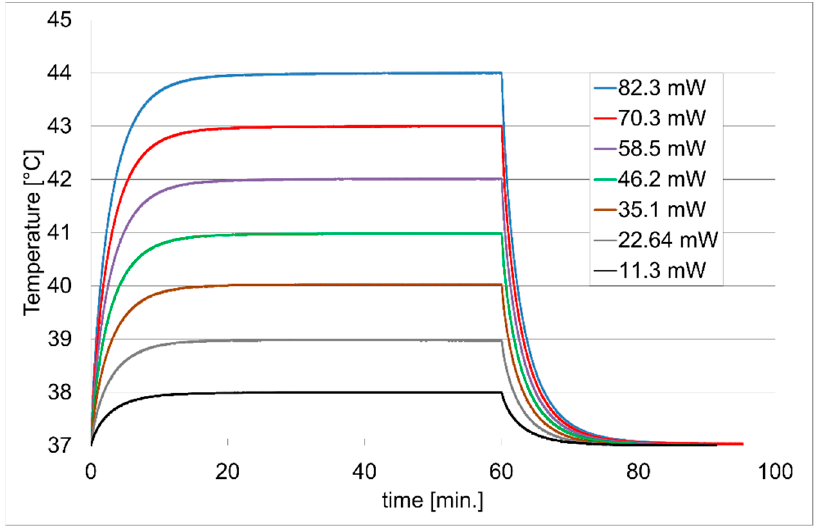
Figure 8. Characteristics for successive temperatures on the electrodes of the capacitor depending on the heating time. After 60 min, the power to the heaters is turned off and the temperature is measured during the return to the initial state (37 °C).